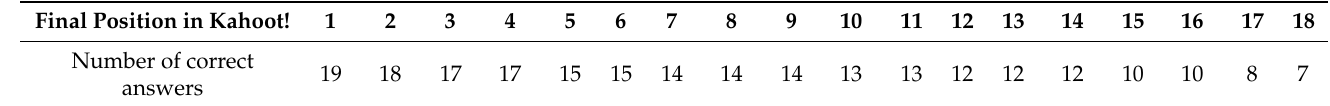
Table 4. Student’s final position in Kahoot! with correct